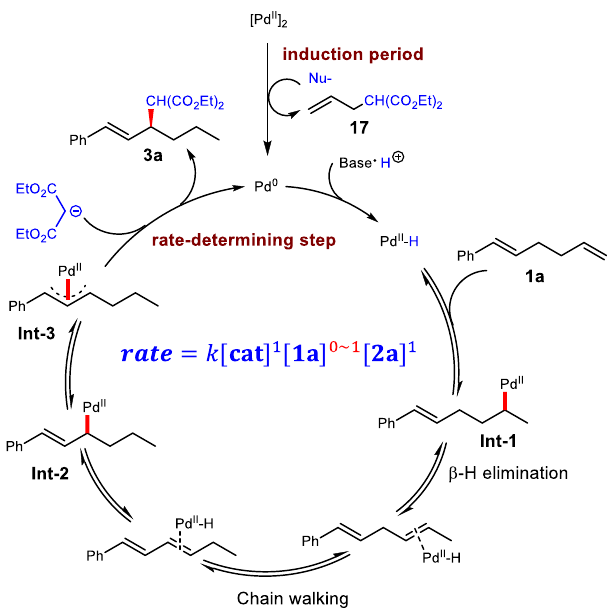
Fig. 6 Proposed mechanism. Pd-catalyzed migratory allylic substitution with outer-sphere